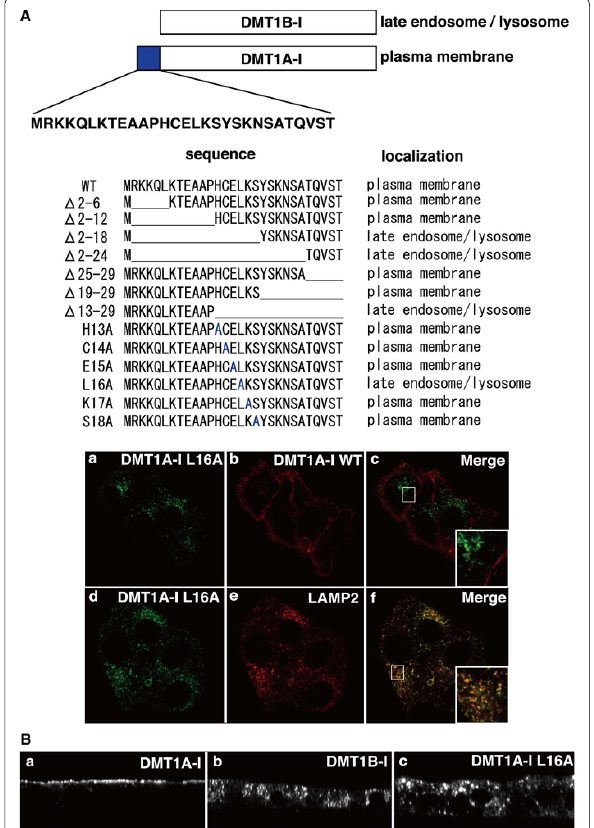
Figure 5 Mutational analysis of the N-terminal cytoplasmic do- main of DMT1A-I reveals the crucial signal for localizing to the plasma membrane . A. Summary of the mutational analysis of the N- terminal cytoplasmic domain of DMT1A-I. Amino acid sequences of the N-terminal cytoplasmic domain of wild-type DMT1A-I and its vari- ous mutants are displayed together with their localizations. GFP- tagged DMT1A-I L16A (a and d) and mCherry-tagged DMT1A-I WT (b) are transfected into HEp-2 cells. The cells were fixed and stained with antibodies against LAMP2 (e). B. MDCK cells stably expressing GFP- tagged DMT1A-I (a), GFP-tagged DMT1B-I (b), and GFP-tagged DMT1A L16A (c) were grown on Transwell and analyzed after their